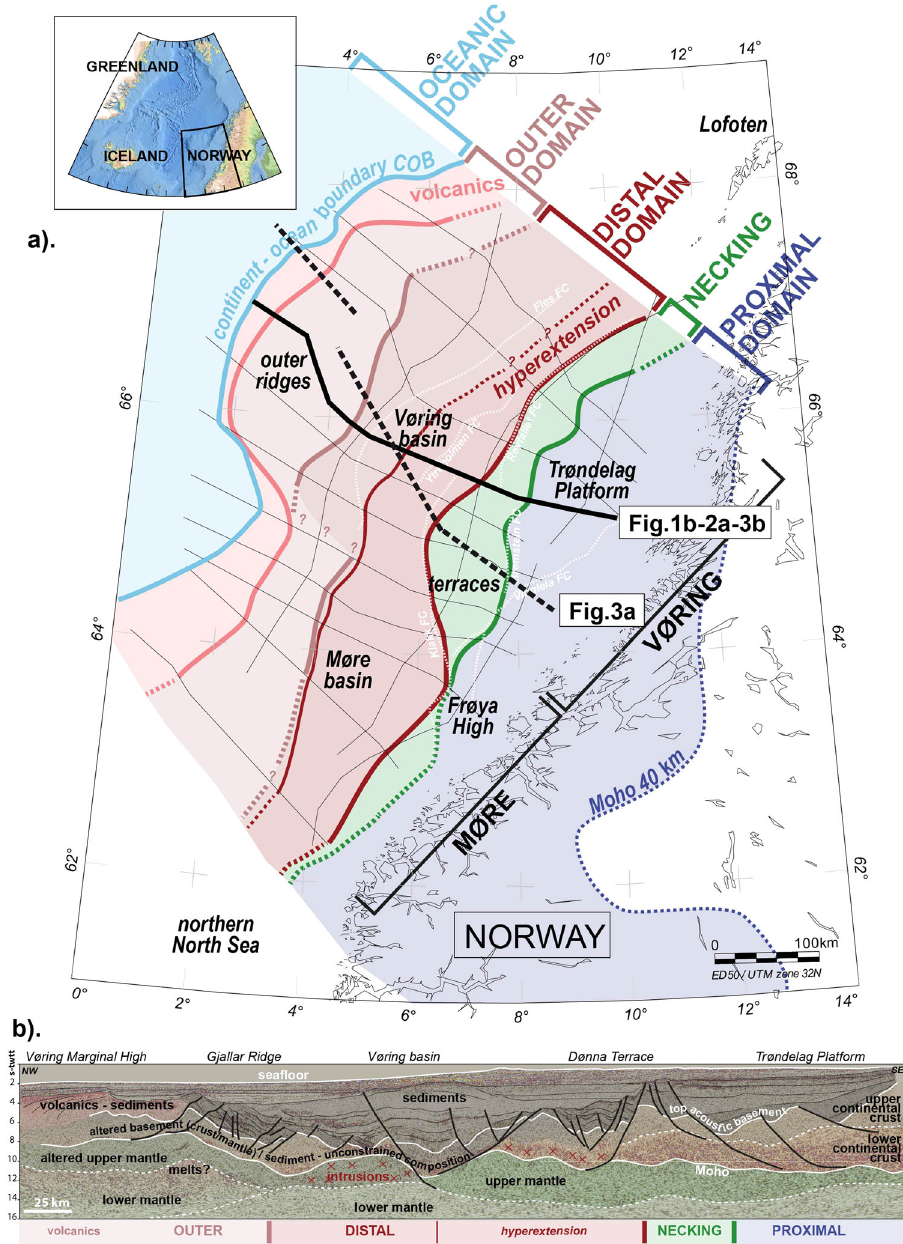
Fig. 1 Map of the structural domains of the mid-Norwegian continental rifted margin. a Map of the study area: the mid-Norwegian rifted margin offshore Norway with the Møre and Vøring margin segments. See top left inset for North-East Atlantic location. The thin black lines show the pro fi les of the seismic re fl ection Geoex MCG RDI19 dataset 53 . The colored polygons represent the different margin domains (proximal, necking, distal, outer, oceanic — see top right bracketed labels). The thick black line localizes the pro fi le presented at the bottom of the fi gure (panel b ) and in Figs. 2 and 3. b Seismic re fl ection pro fi le selected as representative of the global architecture of the Norwegian Continental Shelf. The main envelopes (sea fl oor, top basement, Moho) are drawn as white lines. Dashed white lines represent other important observed seismic facies changes at mid-crustal and mantle depths. The main faults are mapped, together with the main sedimentary and basement units. See the Geological context section for explanations. Modi fi ed after Peron-Pinvidic et al.